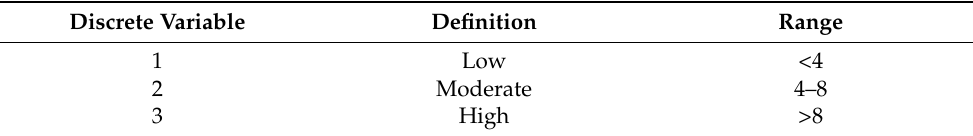
Table 6. Assignation to each category of rainfall erosivity